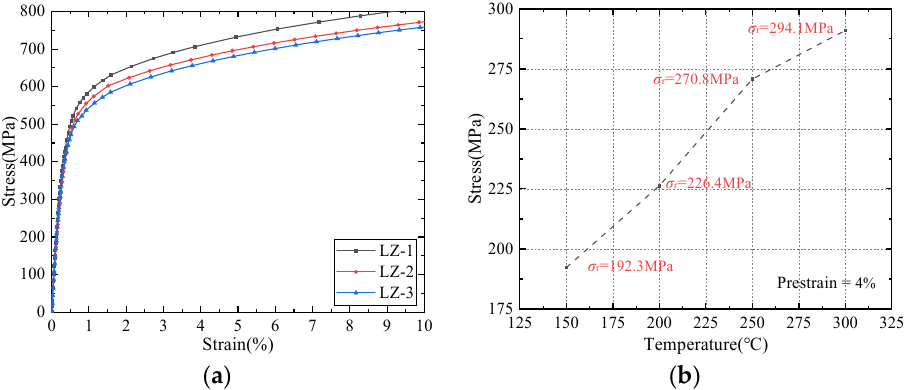
Figure 15. Mechanical properties of China-made Fe-SMA: ( a ) stress–strain curves, ( b ) recovery stresses.